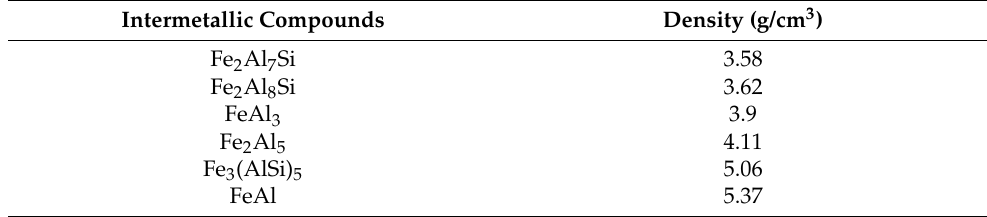
Table 6. Density values of the common Fe x Al y Si z intermetallic compounds